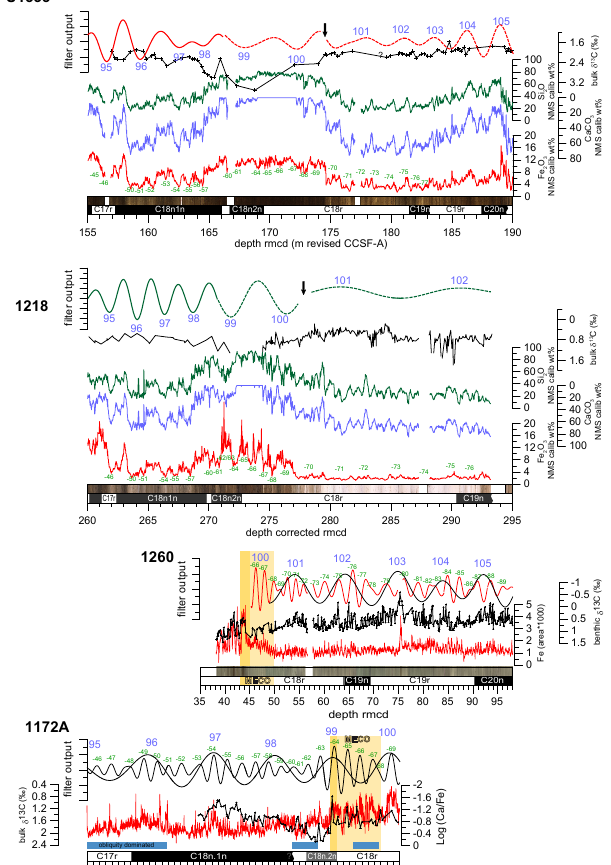
Figure 7. High-resolution XRF core scanning data, bulk and ben- thic stable carbon isotope data, core images, and cyclostratigra- phy from Chron C18n.1n to C20n for Sites U1333, 1218, 1260, and Hole 1172A in the depth domain. For details see caption of Fig. 2. ODP Site 1260 XRF Fe intensity data from Westerhold and Röhl (2013), benthic stable isotope data, and magnetostratig- raphy from Edgar et al. (2007). ODP 1172A XRF data from Röhl et al. (2004), bulk δ 13 C data from Bijl et al. (2010). Extend of the MECO is marked by a light orange bar and the carbon iso- tope excursion at the end of the MEO is marked by a orange bar in 1260 and 1172A (for correlation details see Supplement Fig. S10). Arrows mark change in phase relation between stable isotope and XRF core scanning data. 405kyr band pass filters: for Site U1333 from Fe data (155–165rmcd 0 . 36 ± 0 . 110cm − 1 ; 165– 175rmcd 0 . 25 ± 0 . 07cm − 1 ; 175–190rmcd 0 . 36 ± 0 . 1cm − 1 ; 2.78, 4, and 2.78m bands in Fig. S6c); for Site 1218 from Si data (260– 270rmcd 0 . 42 ± 0 . 105cm − 1 ; 270–278rmcd 0 . 22 ± 0 . 05cm − 1 ; 278–293rmcd 0 . 11 ± 0 . 027cm − 1 ; 2.38, 4.55, and 9.09m bands in Supplement Fig. S5b); for Site 1260 from benthic stable carbon iso- tope data (0 . 1 ± 0 . 03cm − 1 ); and for Hole 1172A from log ( Ca / Fe ) data (0 . 1 ± 0 . 03cm − 1 ). Note the dominant obliquity component in Hole